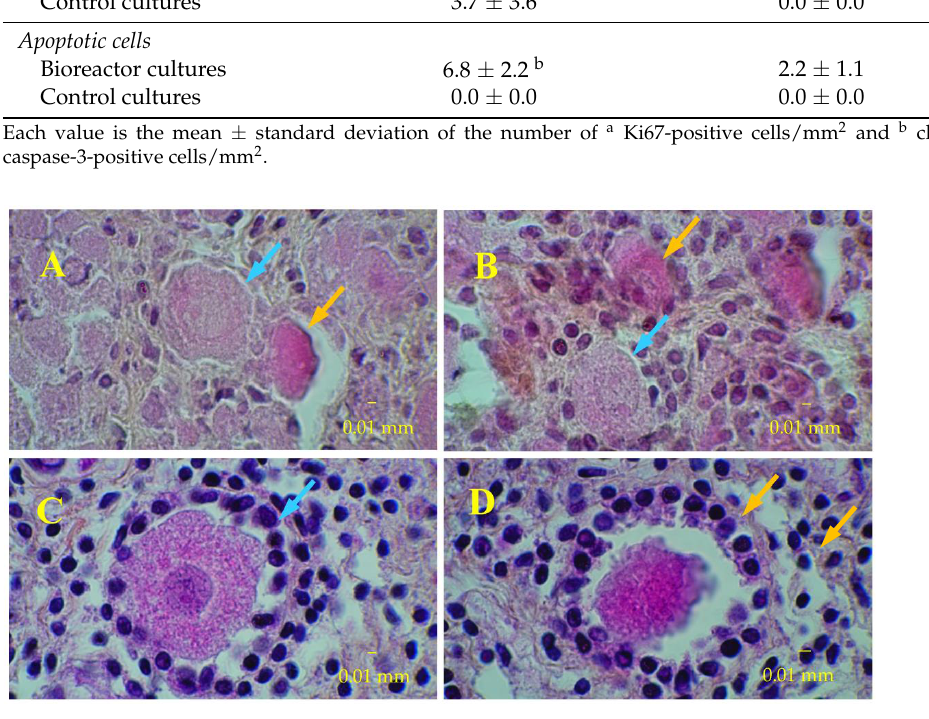
Table 3. Densities of proliferating and apoptotic cells according to the culture type and time.